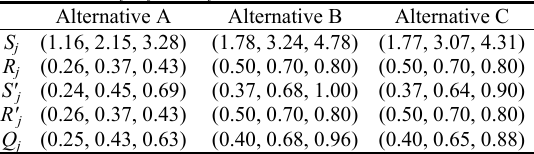
Table 8. S j , R j and Q j values for v = 0.8